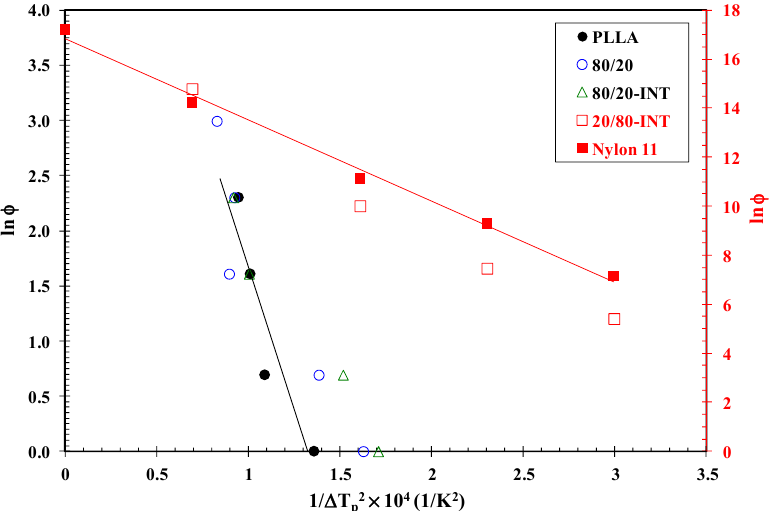
Figure 7. Dobreva plots of PLLA, nylon 11, PLLA/nylon 11 blends and the PLLA/nylon 11-INT nanocomposites obtained from non-isothermal crystallization traces after fitting the data at the cooling rates of 1, 2, 5, 10 and 20 °C/min.